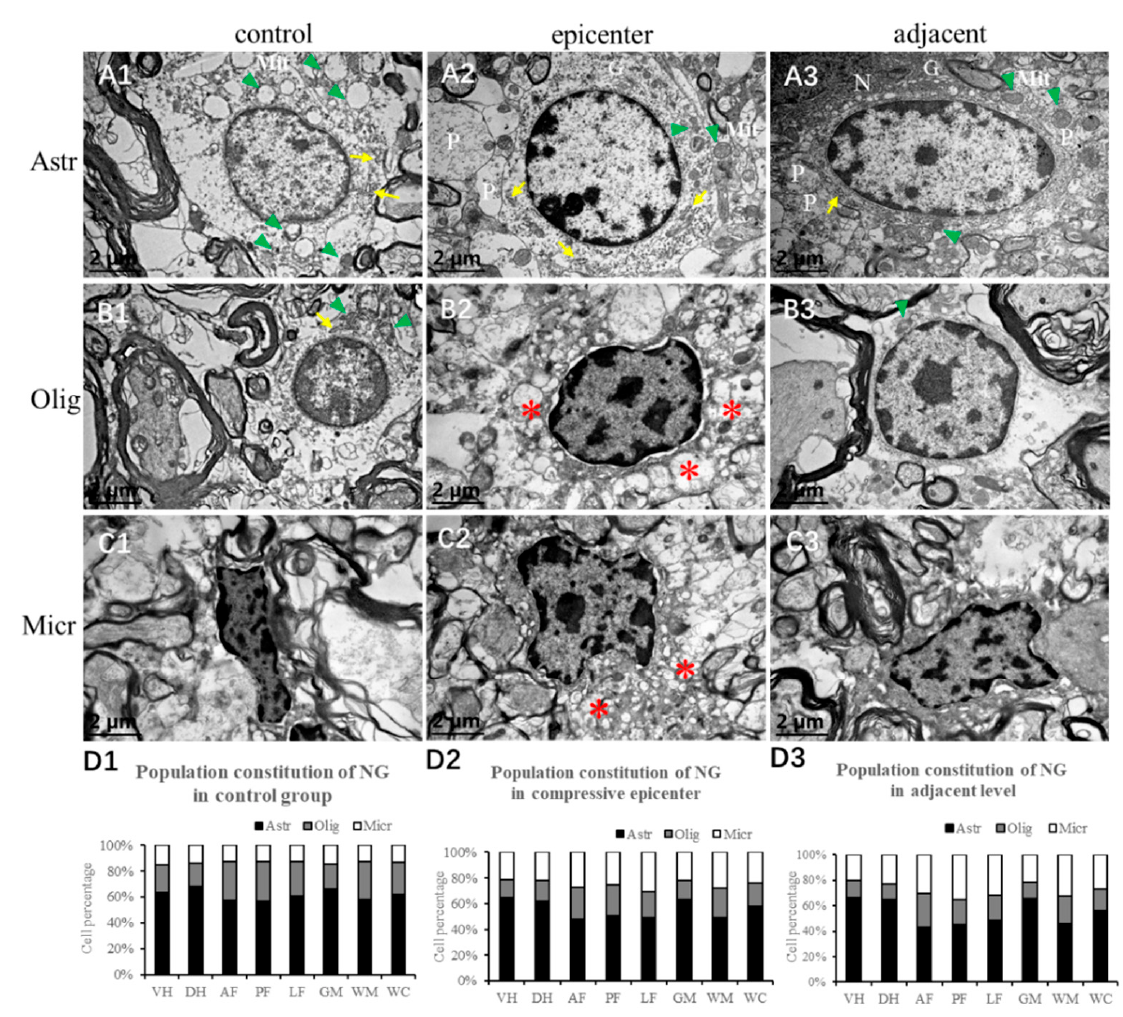
Figure 8. Morphology of neuroglial cells by TEM examination. ( A1 – A3 ) Astrocytes (Ast) exhibited even distribution and low-density karyoplasm with abundant cytoplasm and cytoplasmic organelles such as granular endoplasmic reticulum (yellow arrow), Golgi complexes (G), ribosomes and mitochondria (green arrowhead), as well Nemours processes (P); ( B1 – B3 ) Oligodendrocytes (Olig) were smaller than the astrocytes with dense clumped chromatin aggregated eccentrically around the rim of the karyolemma. Numerous phagocytosed vacuolations (*) were identified; ( C1 – C3 ) Microglial cells (Micr) appeared to have irregular morphology and with clumped chromatin. Numerous phagocytosed vacuolations (*) were seen in the compressive epicenter. ( D1 – D3 ) Population constitution of neuroglial cells (NG) in different anatomic regions.